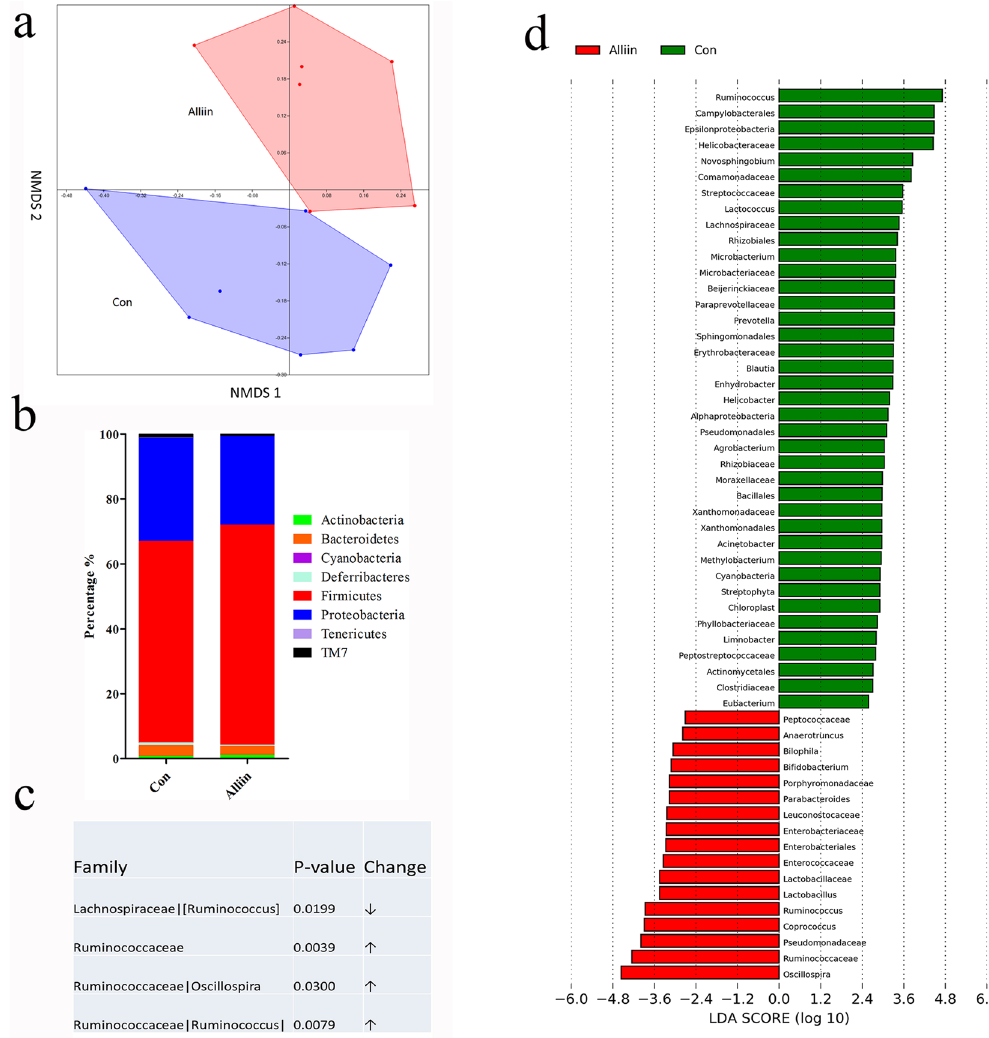
Figure 5. Analysis of intestinal microbiota. ( a ) NMD plots showed a significant difference in intestinal taxonomic composition between the alliin treated mice and the control. ( b ) In general, alliin increased the dominant bacteria of Actinobacteria and Firmicutes but decreased Bacteroidetes and Proteobacteria (no statistical difference). ( c ) Four groups of bacteria with significant differences were selected as in a table. (averaged reads over 100 and the percentage in its phylum over 1%). ( d ) Detailed abundance change was shown here. Red indicated that this taxon was more prevalent in the alliin group, while green indicated the taxon was more prevalent in the control group. Data are means ± SEM (n =